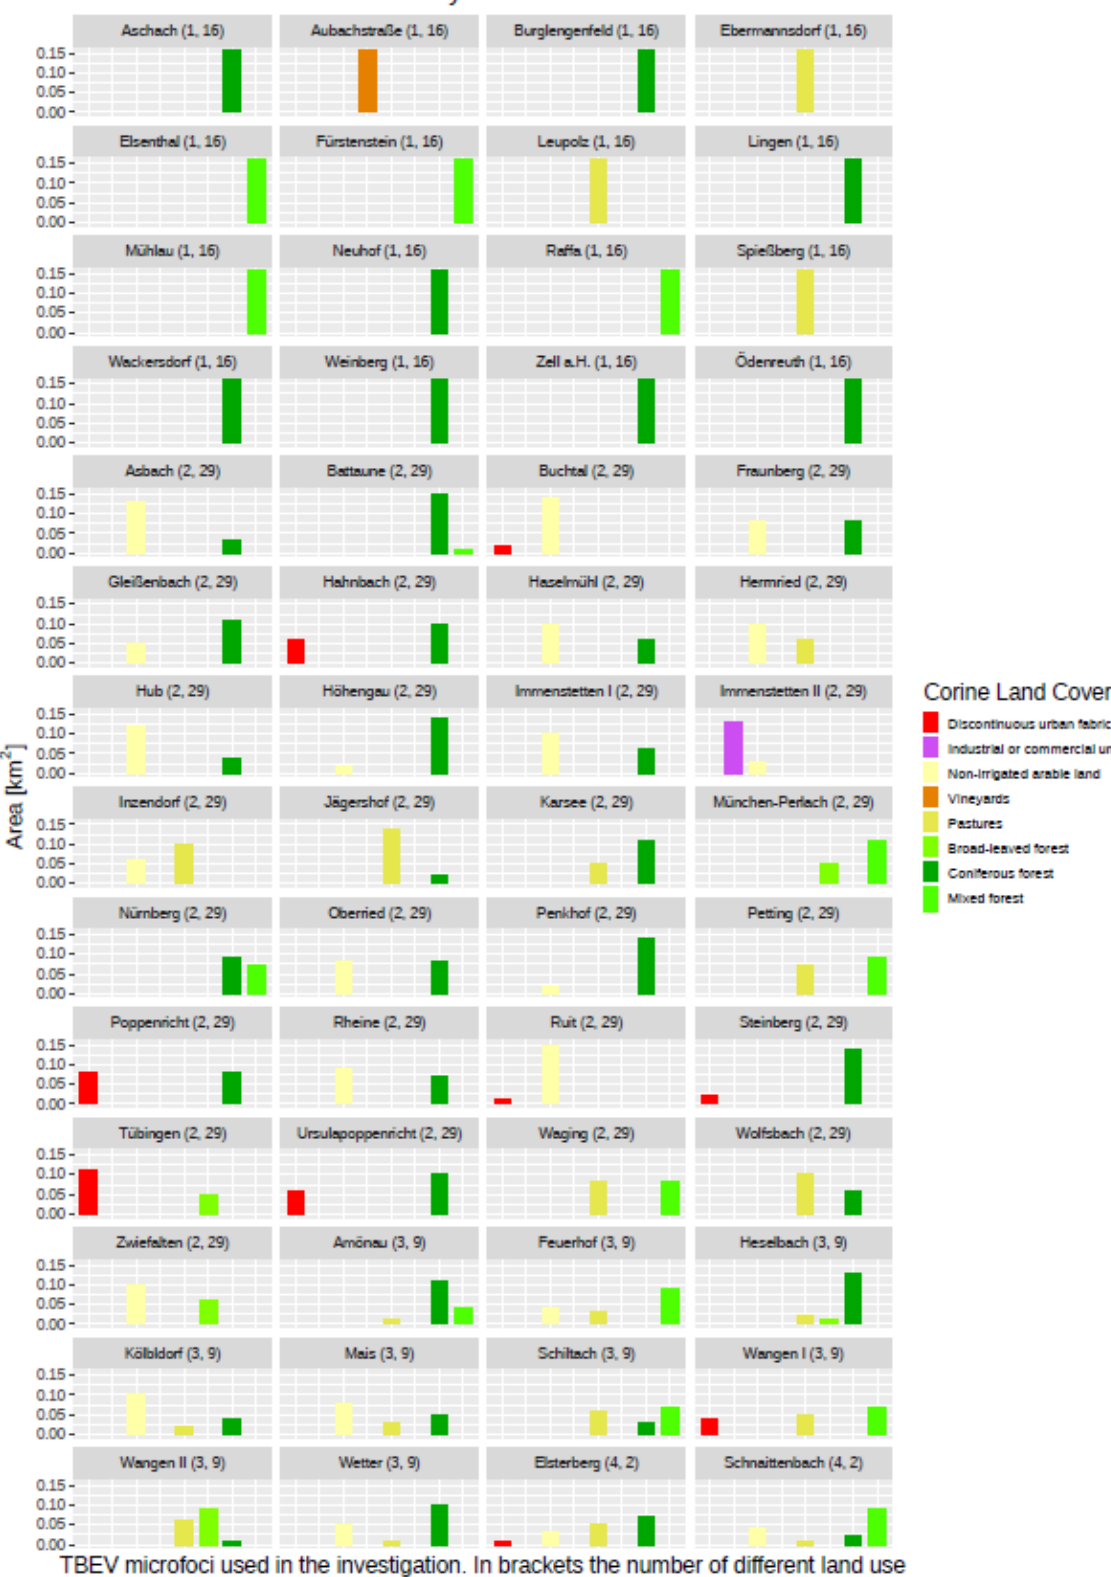
Figure 2. Overview regarding TBEV microfoci and the surrounding land cover classes within 400 × 400 m.